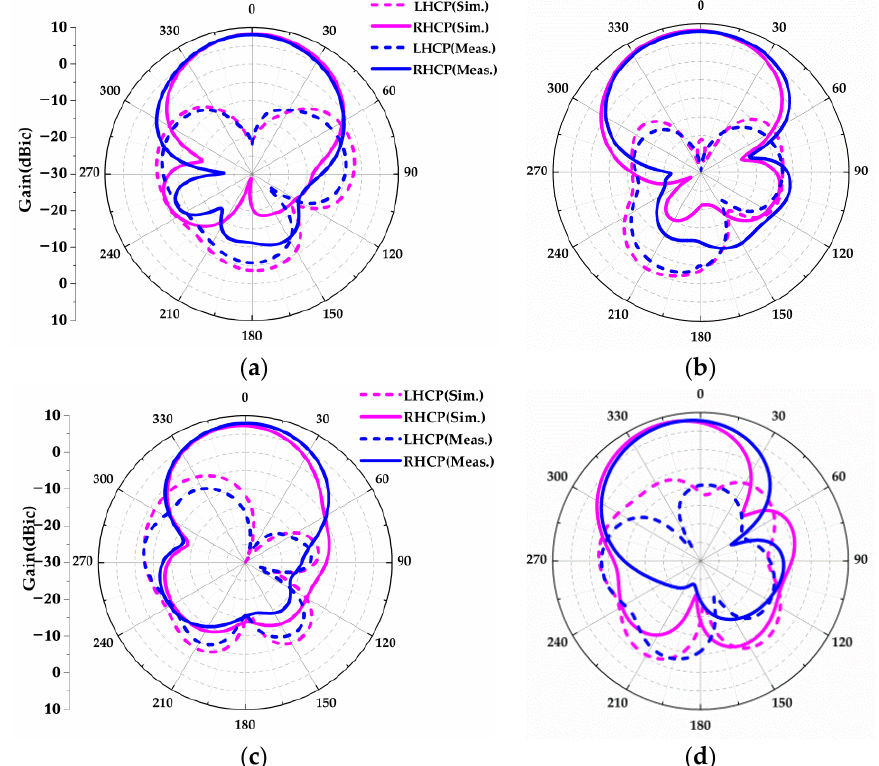
| ; ( b ) AR and gain. 11